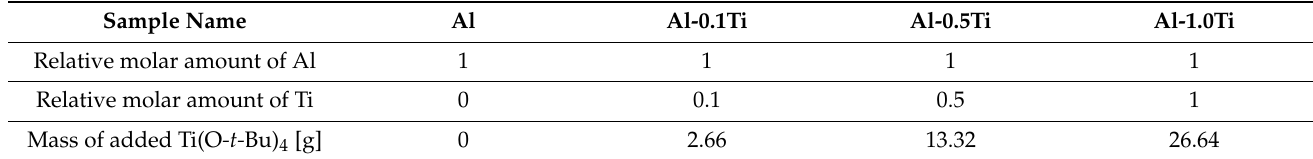
Table 1. Composition and labeling of the studied systems and the amount of added titanium t-